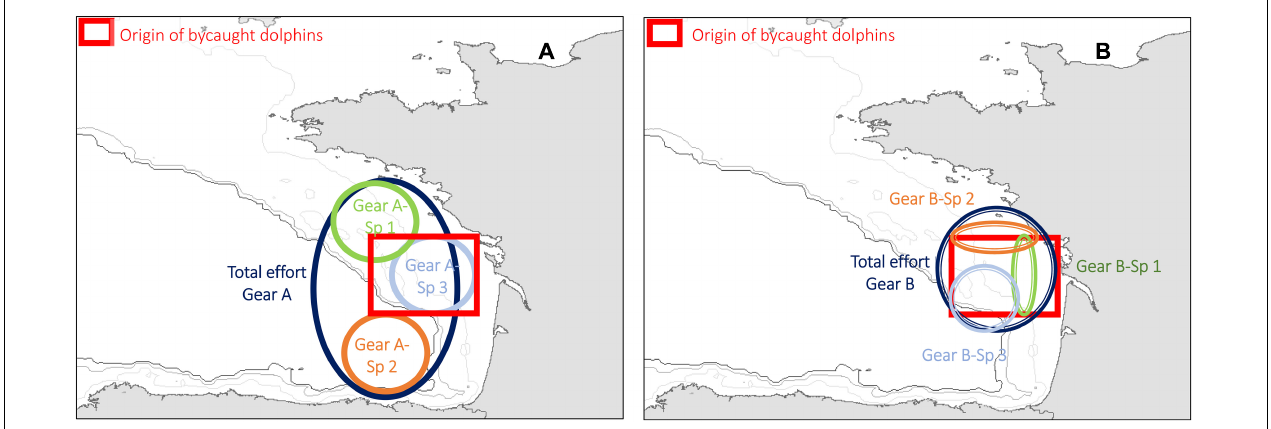
FIGURE 8 | Theoretical co-occurrence of the origin of stranded dolphins and fishing effort in two distinct scenarios. The red box represents the origin of stranded bycaught dolphins. In panel (A) , the total effort of gear A is presented and only the effort dedicated to catching species 3 correlates with the origin of the strandings. In panel (B) , the origin of the strandings is positively correlated with the total fishing effort including all three species; individually considered, fishing effort for each of the different species is not